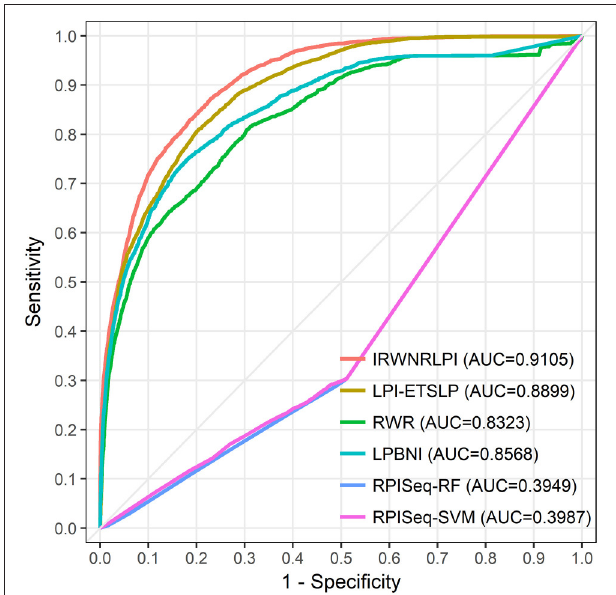
FIGURE 3 | The ROC curves of IRWNRLPI, LPI-ETSLP, RWR, LPBNI, RPISeq-RF, and RPISeq-SVM are expressed in red, brown, green, blue, purple and pink, respectively. The light gray line represents the ROC curve of the interaction between IRWNRLPI and the randomized lncRNA-protein pairs.